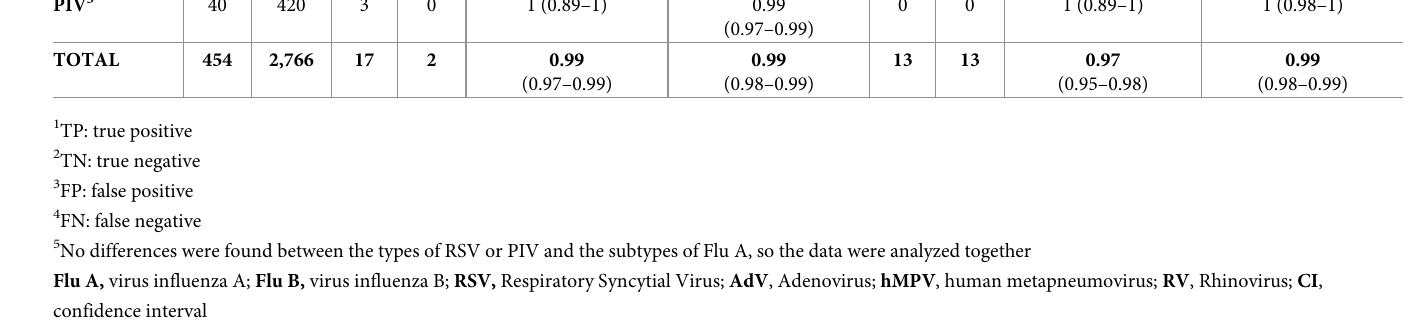
Table 3. Globally, both tests showed excellent sensitivity and specificity values; Panther Fusion had sensitivity values > 0.95 for all viral targets, whereas Allplex showed values lower than 0.95